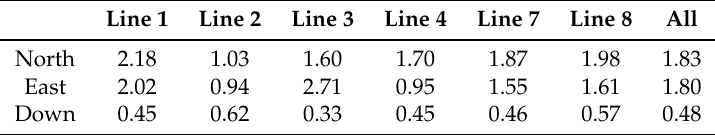
Table 5. Repeatability of data fusion results